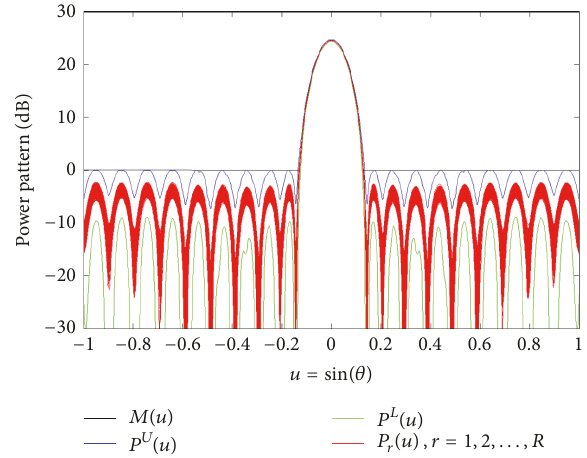
Figure 5: BW interval based on IA against ISLL ref .